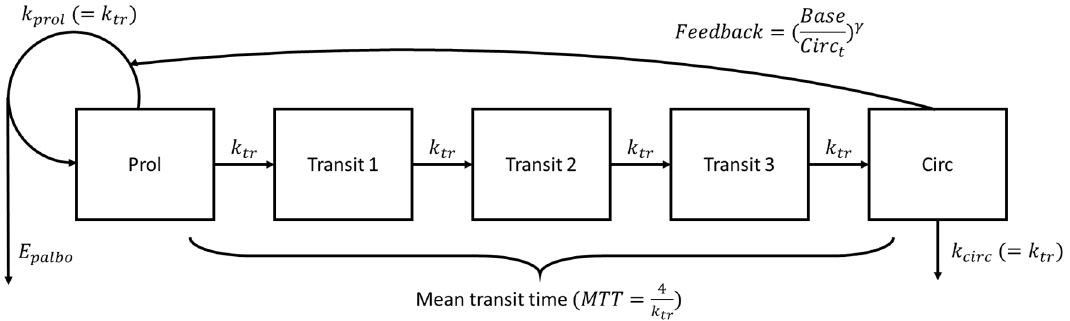
Figure 1. Semi-mechanistic PK/PD structural model describing neutropenia after palbociclib admin- istration [18]. E palbo : palbociclib effect parameter described by an E max model, k prol : net proliferation rate constant, k tr : transit rate constant, k circ : physiological neutrophil elimination rate constant from systemic circulation, MTT: mean transit time through the maturation delay chain, Prol: proliferating progenitor cells, Circ: circulating cells, Base : baseline value of circulating cells, Circ t : circulating cells at a given time t, γ : power factor for the feedback mechanism.